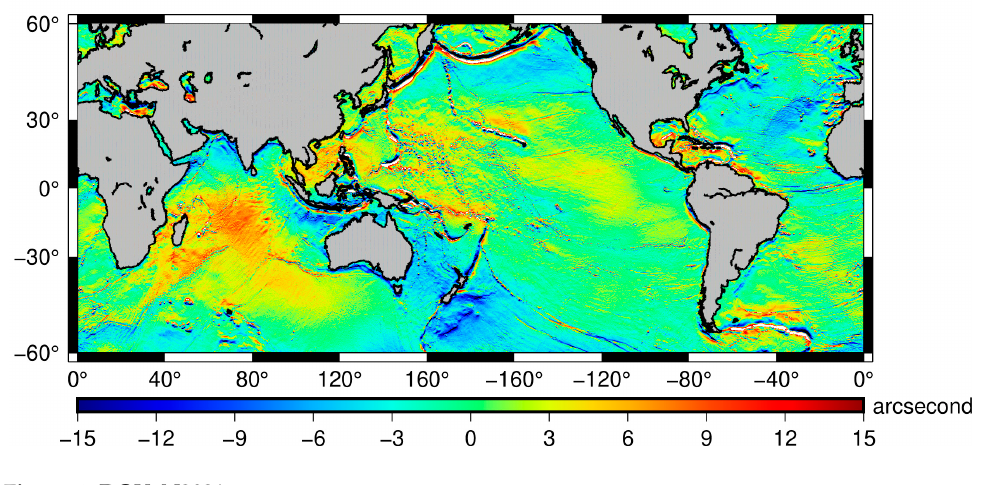
Figure 4. DOV_N2021.